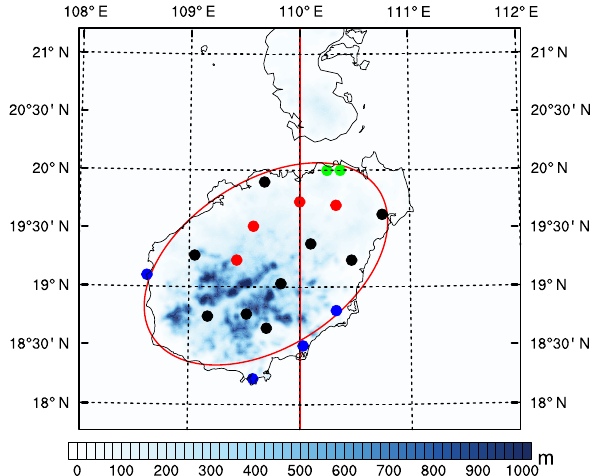
Figure 1. Configuration of model domain, gauge-based station points (colored dots correspond to the time series shown in Fig. 2) over Hainan Island and the terrain height (shading, m). The red el- lipse is the idealized representation of the island (used for the ideal- ized simulations), and the red vertical line indicates the location of the vertical cross sections shown in Figs. 14 and